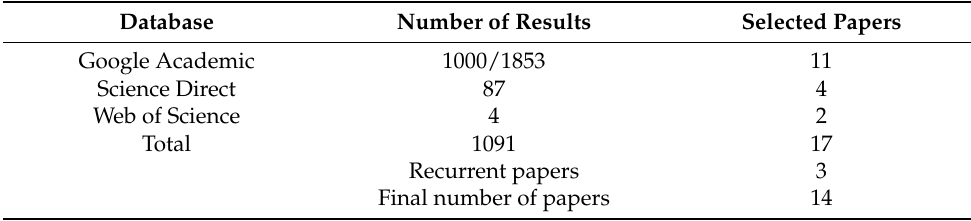
Table 1. Selected papers from databases.